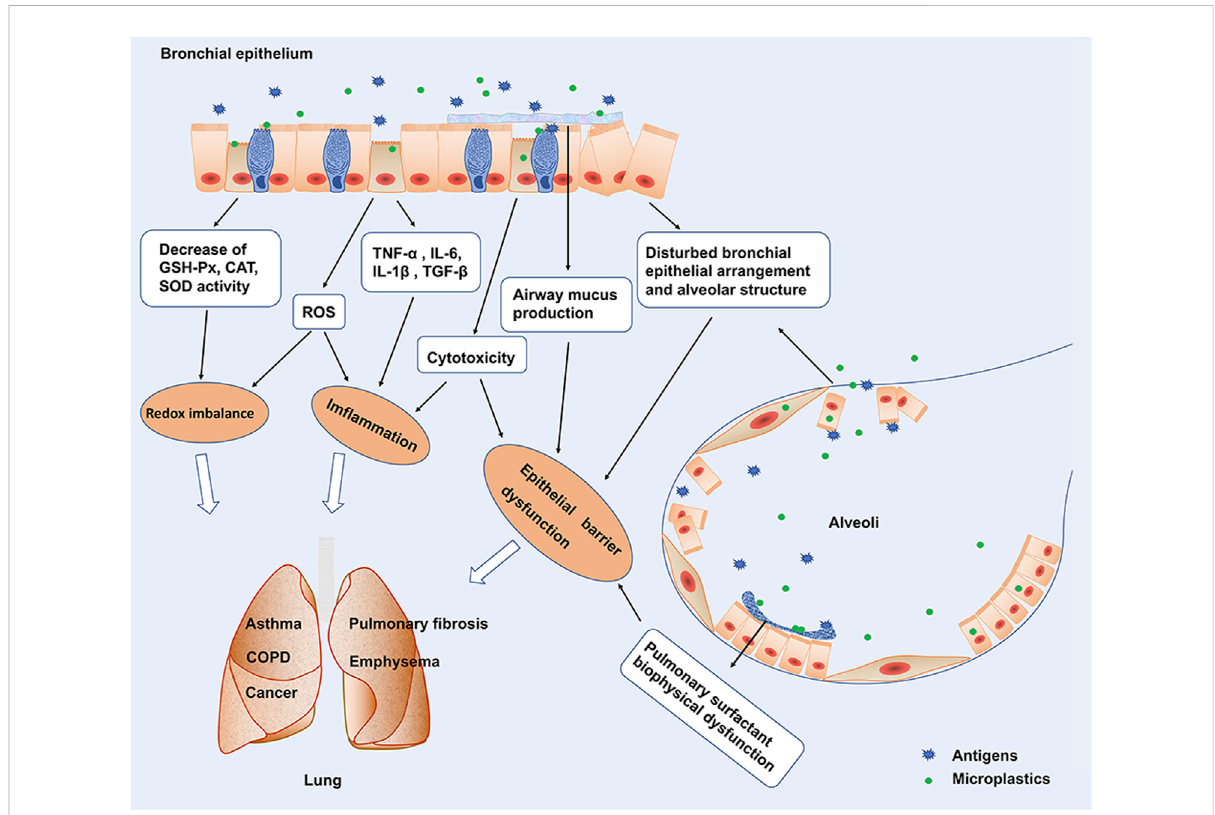
FIGURE 1 Potential effects and possible mechanisms of microplastics on respiratory. Microplastic exposure interferes with the biophysical function of pulmonary surfactants and disrupts alveolar structure and airway barrier function. Exposure of microplastics to lung epithelial cells inhibits epithelial cellproliferationandinducesepithelialcellapoptosis.Microplasticsstimulatestheproductionofpro-in fl ammatorycytokinessuchasTNF- α ,IL-6,IL- 1 β production, and TGF- β production by lung epithelial cells. In addition, exposure to microplastics caused a signi fi cant decrease in oxidative stress-related GSH-Px, CAT, and SOD activities, induced ROS production, and Redox